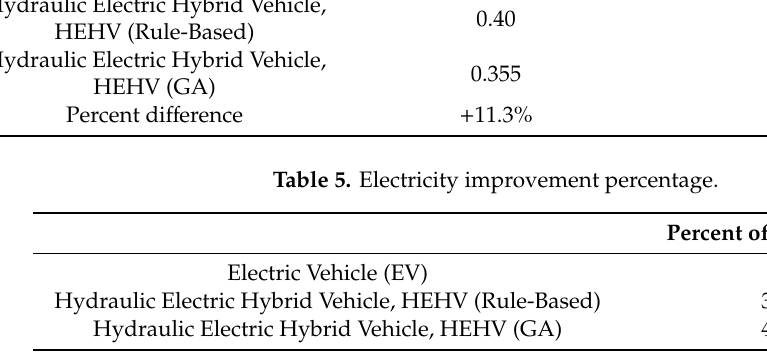
Table 5. Electricity improvement percentage.